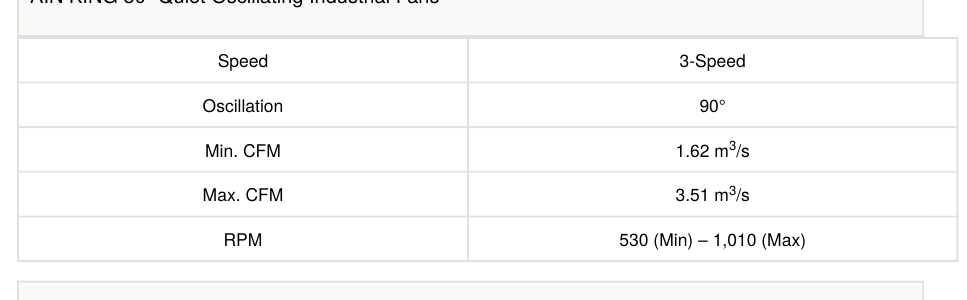
AIN KING 30” Quiet Oscillating Industrial Fans